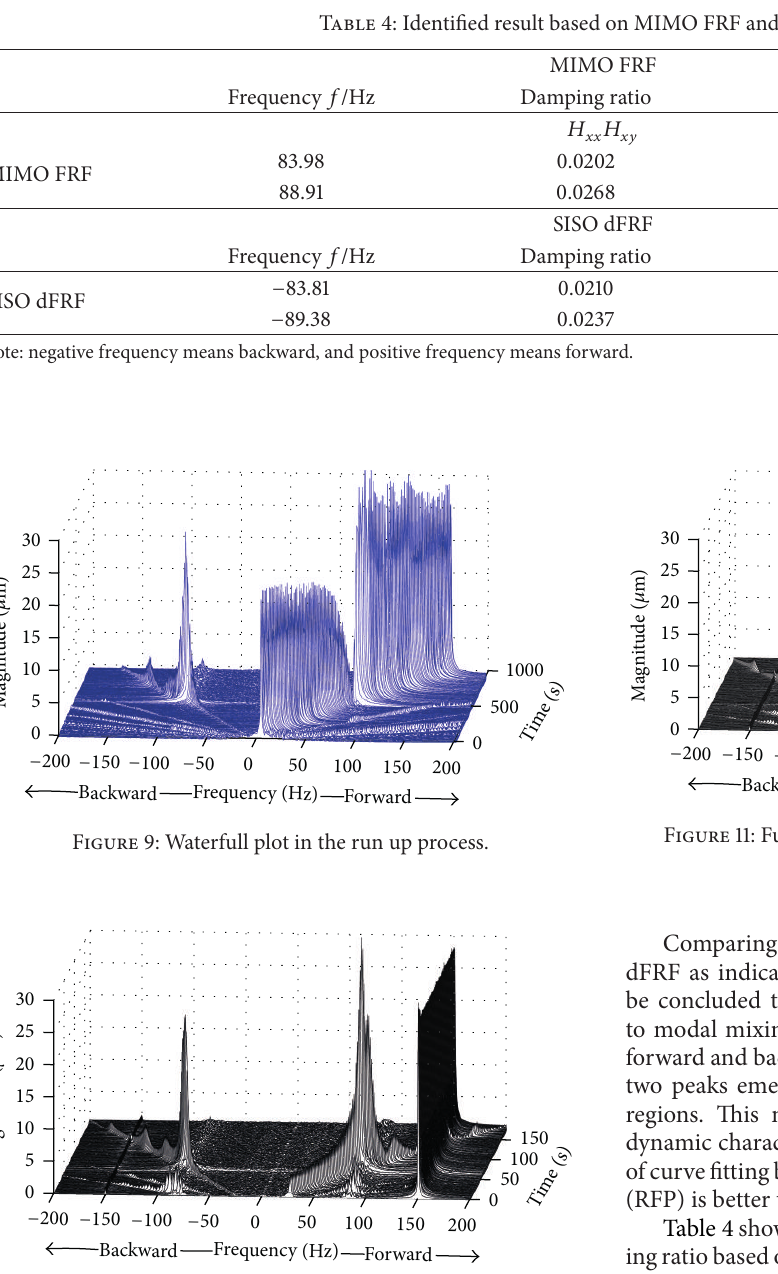
Figure 10: Full spectrum waterfalls at forward excitation.